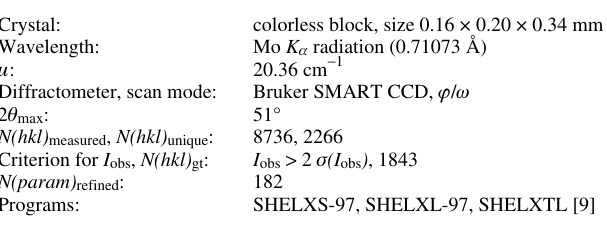
Table 1. Data collection and